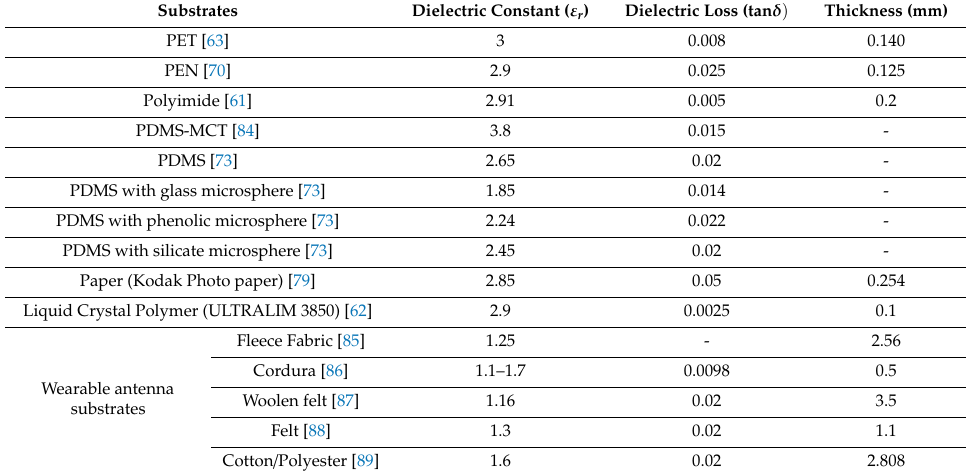
Table 2. Commonly used flexible substrates with their dielectric constant, loss tangent, and thickness.